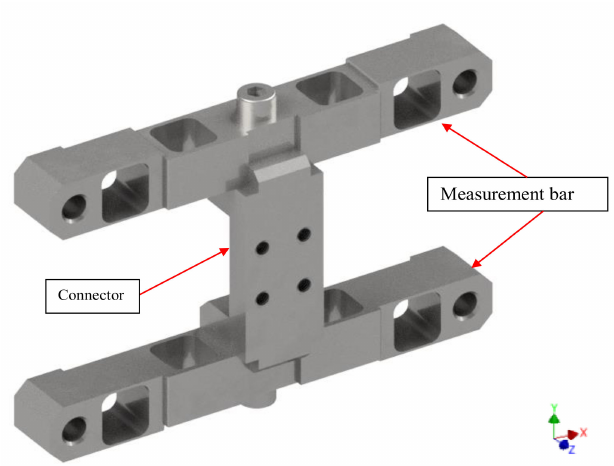
Figure 4. Overview of the transducer.